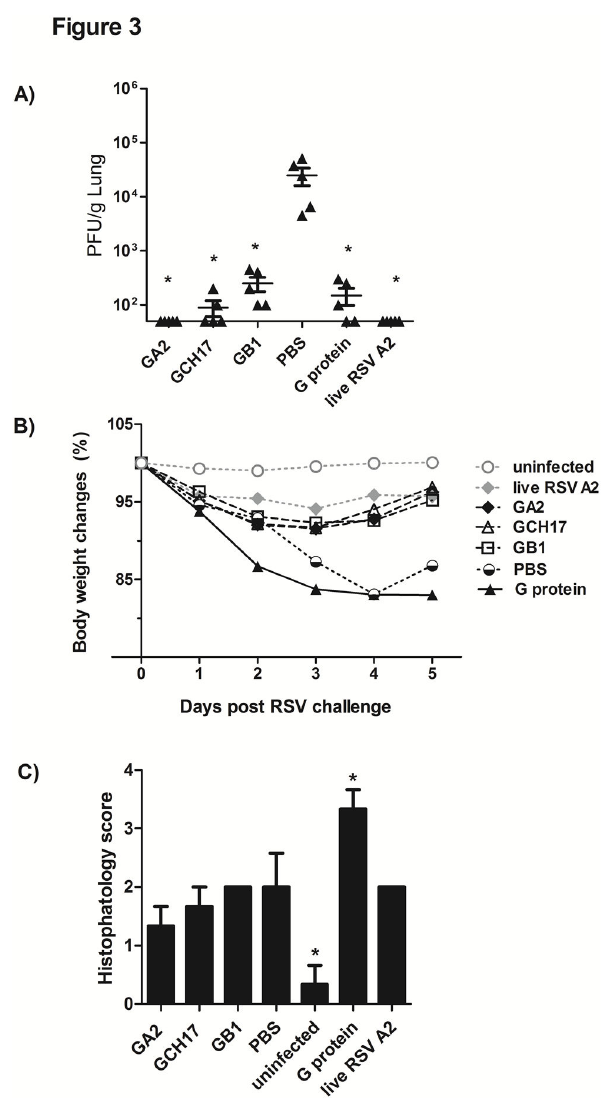
Figure 3. Lung virus titers and body weight loss following RSV A2 challenge of vaccinated mice. Groups of